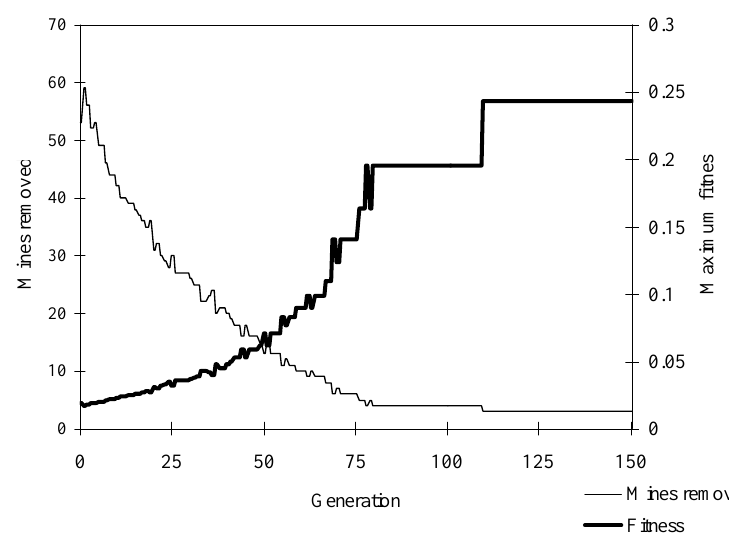
Figure 12: Convergence of the